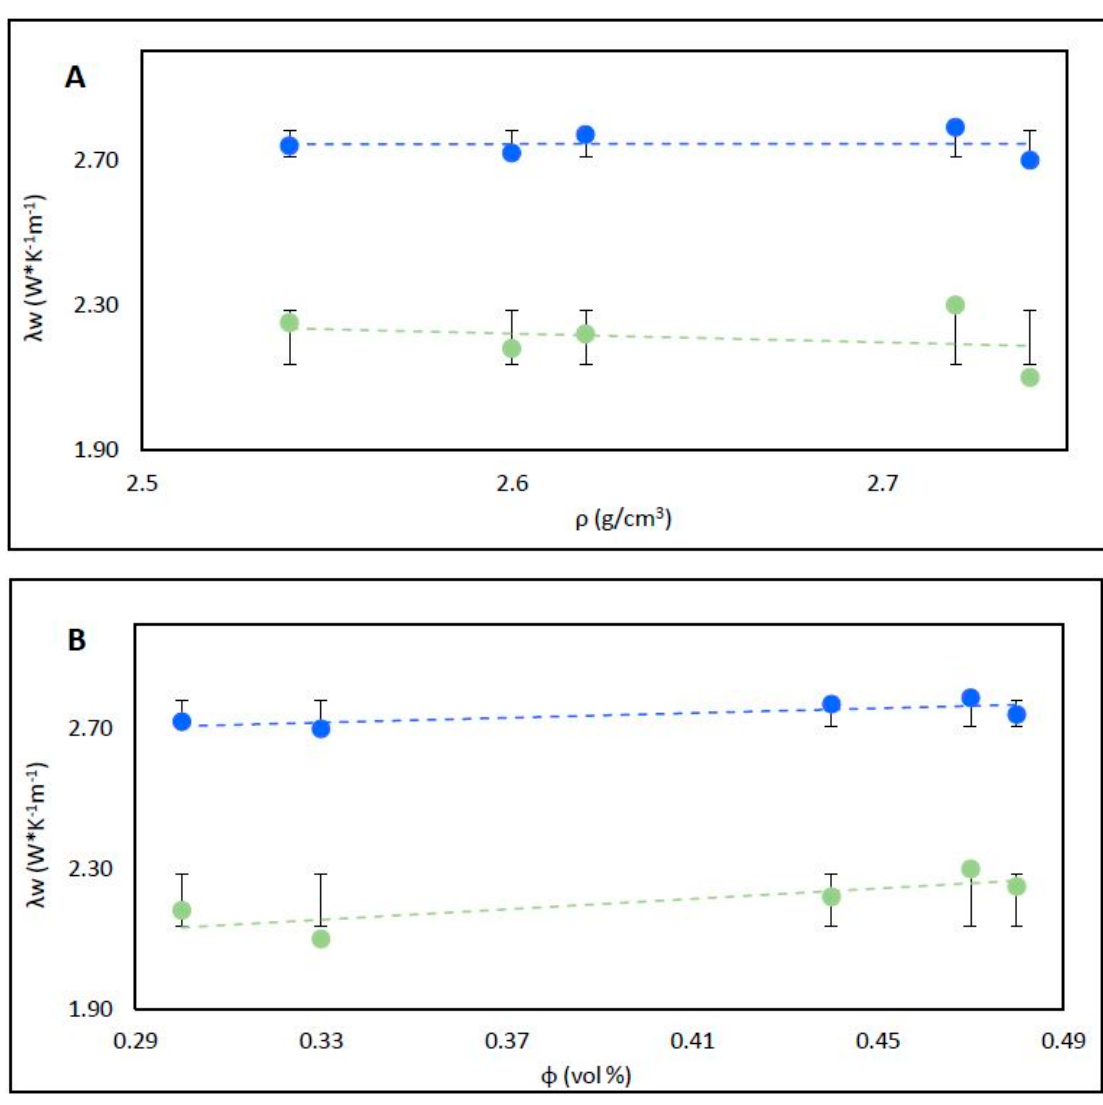
Figure 14. Wet thermal conductivity ( λ w , W*K − 1 m − 1 ) from TLS (green circles) and TDB methods (blue circles) vs. density ( ρ , g/cm 3 ) in ( A ), and porosity ( φ , vol %) in ( B ), respectively. Error bars represent standard deviation.